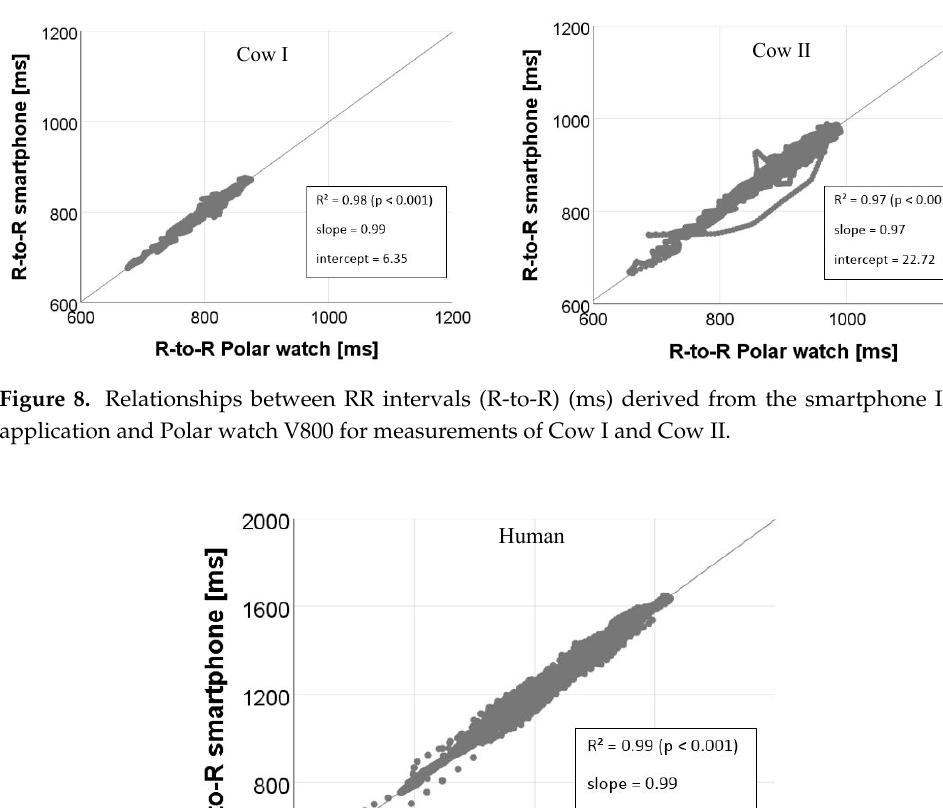
Figure 7. Simultaneous RR interval (R-to-R) (ms) measurements for Cow I during 27 min of recording after outlier removal and interpolation acquired with smartphone IoTool application and Polar watch V800 ( r = 0.98; p < 0.001).